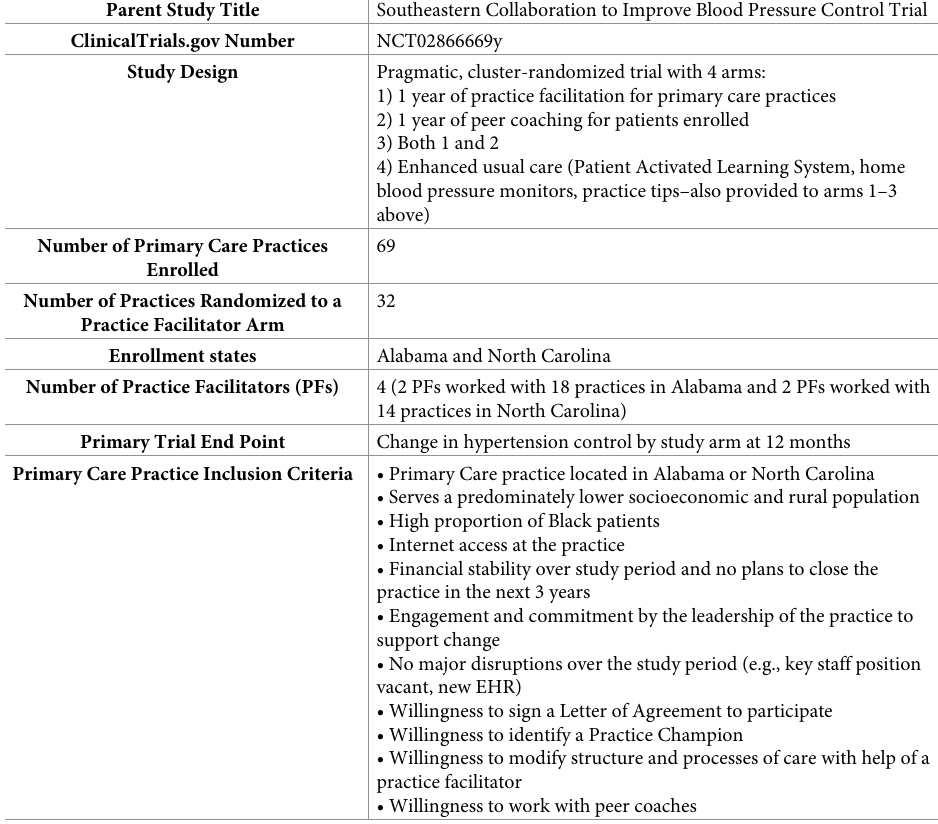
Table 1. Parent study